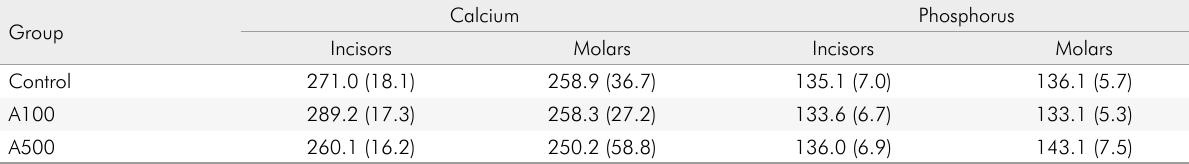
Table 2. Mean (SD) Calcium (Ca) and Phosphorus (P) content in mg/g of tooth. A100 = amoxicillin 100 mg/kg/d and A500 = amoxicillin 500